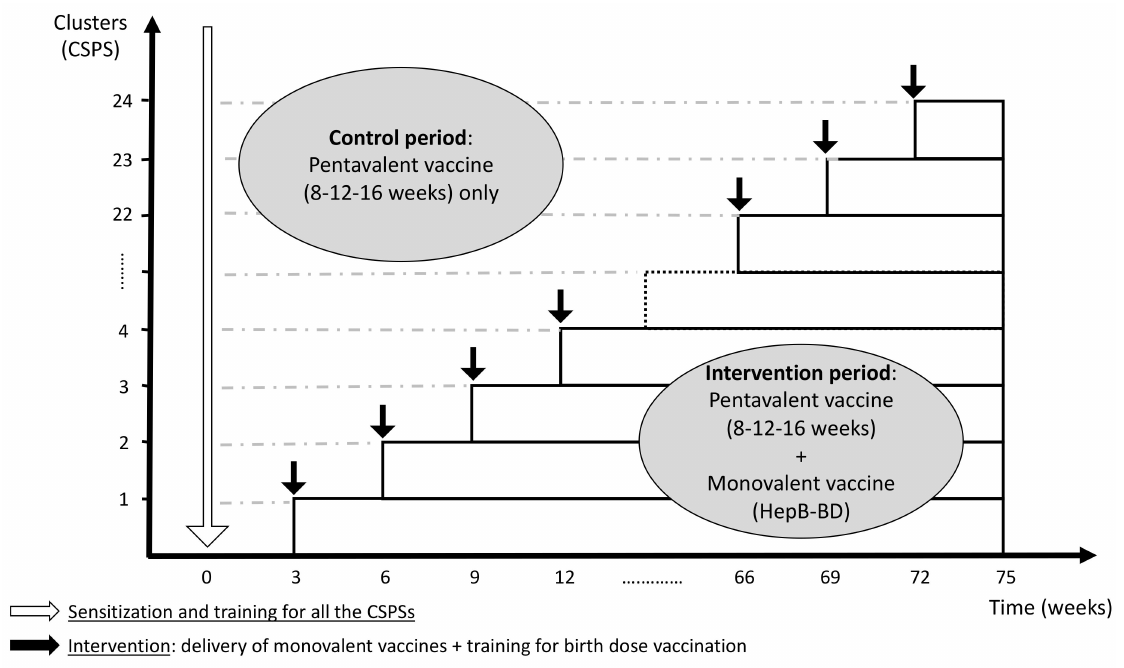
Figure 1. Schematic representation of the stepped wedge design (24 clusters with an interval of 3 weeks per